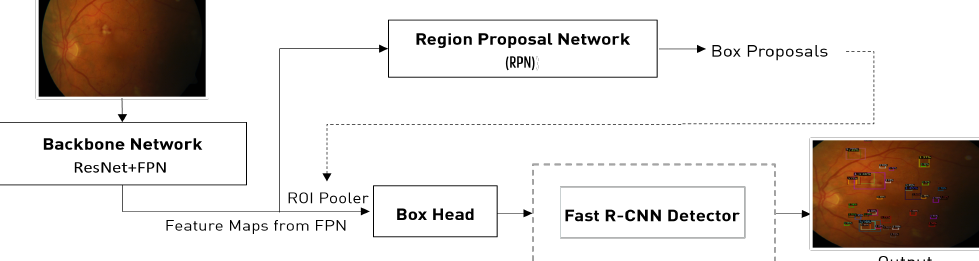
Figure 4. The architecture of Faster R-CNN (R50-FPN) consists of 3 stages: (1) Backbone Network, (2) Region Proposal Network (RPN), (3) Box Head, and Fast R-CNN for object identification. Mask R-CNN (R50-FPN) employs the same 3-step procedure as Faster R-CNN (R50-FPN), but also includes a binary mask produced for each ROI in addition to class and box offset predictions in the third